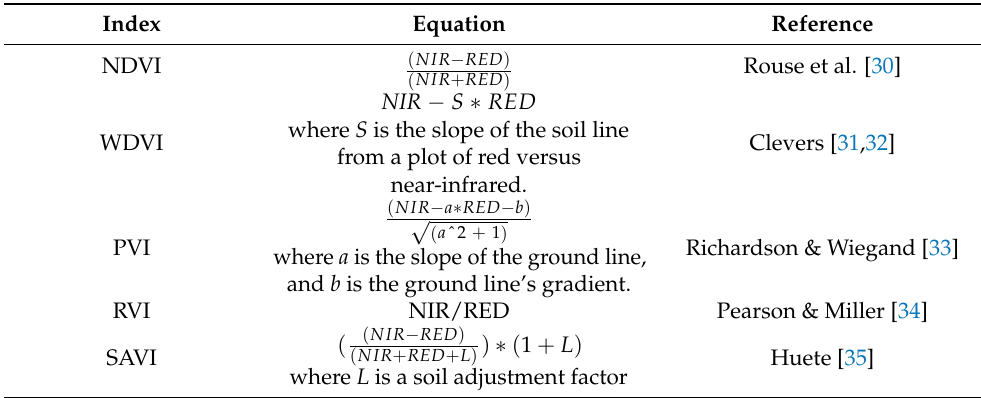
Table 2. The selected VIs used in this study and their respective spectral equations. Index Equation Reference